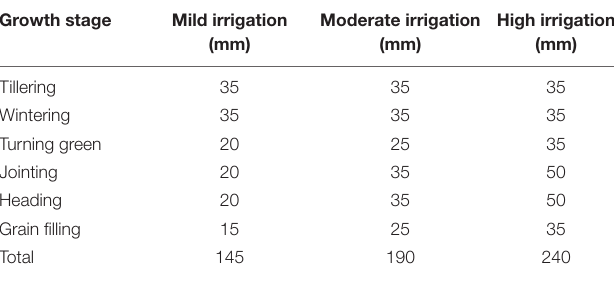
TABLE 1 | Irrigation strategy for each